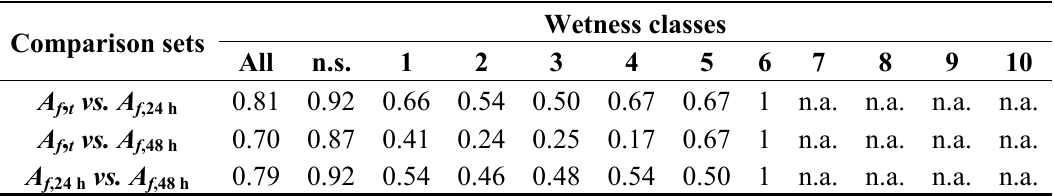
-values predicted based on the 24 h ( A f -values computed with measured weather f Wetness classes